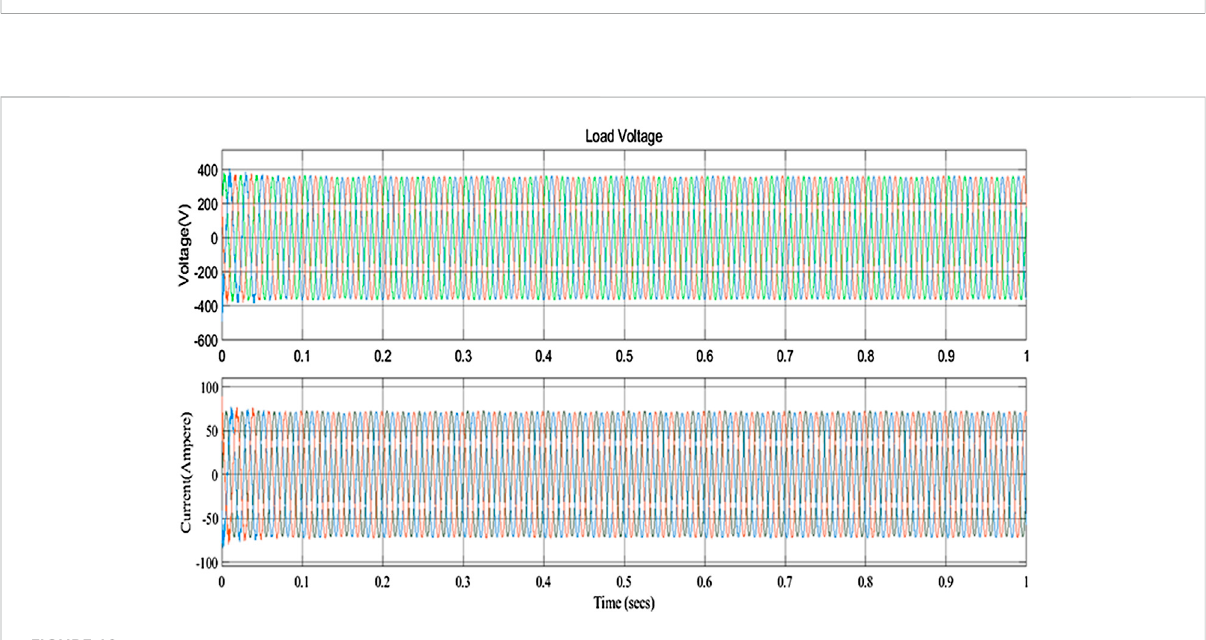
FIGURE 9 Wind-based DC-DC converter waveform.